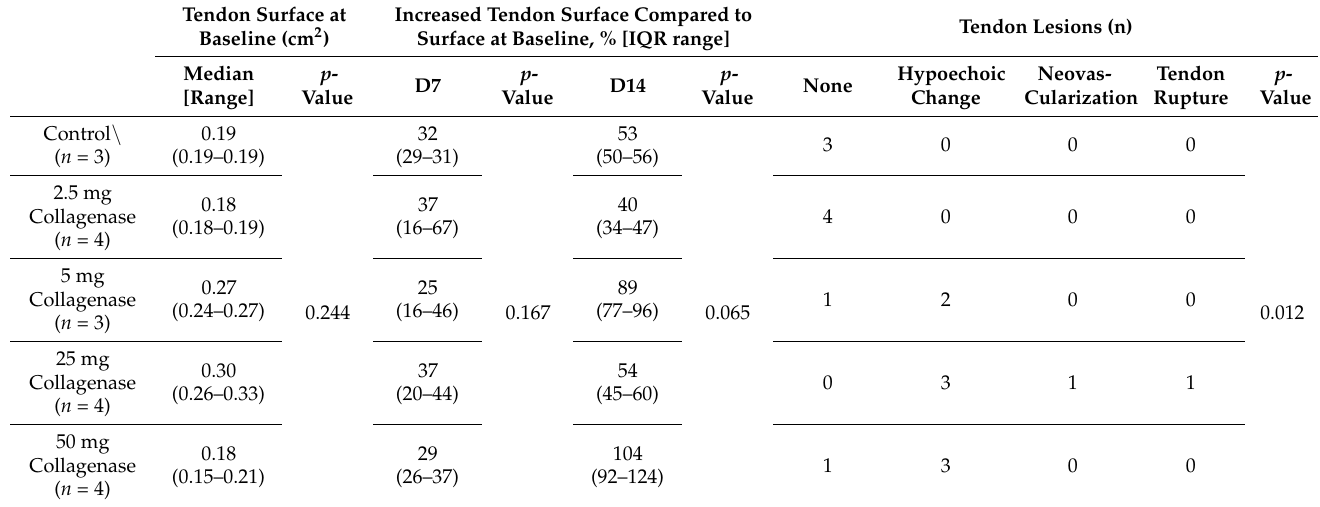
Table 1. Ultrasound evaluation of patellar tendon (surface and morphological changes) at D0 and at D7 and D14 after direct injection of collagenase inside the